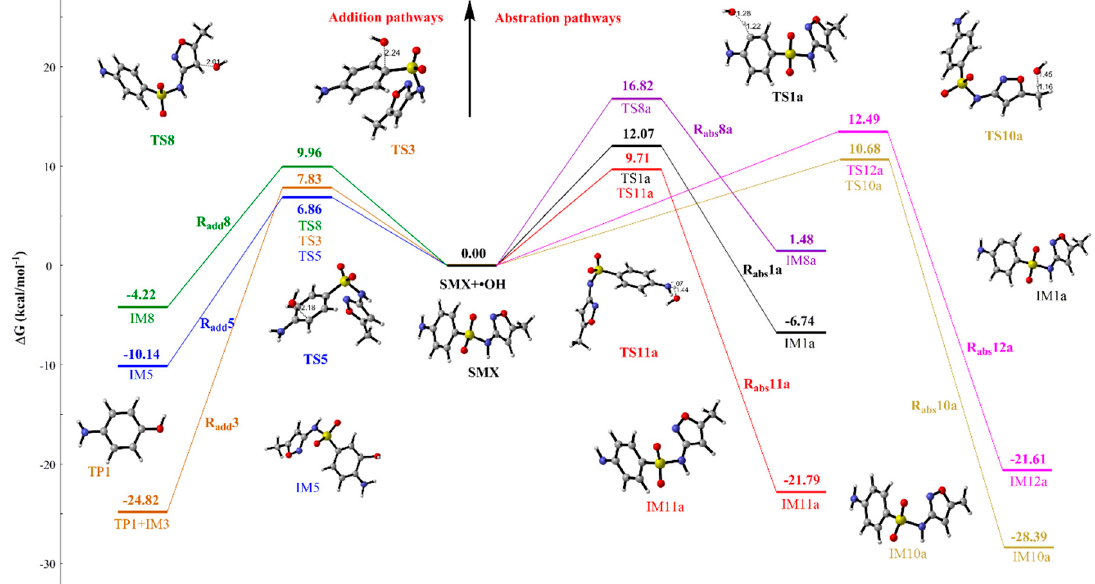
Figure 2. Schematic diagram of free energy for the reactions of SMX with •OH at different sites at the M06-2X/6–31+G (d, p) level.